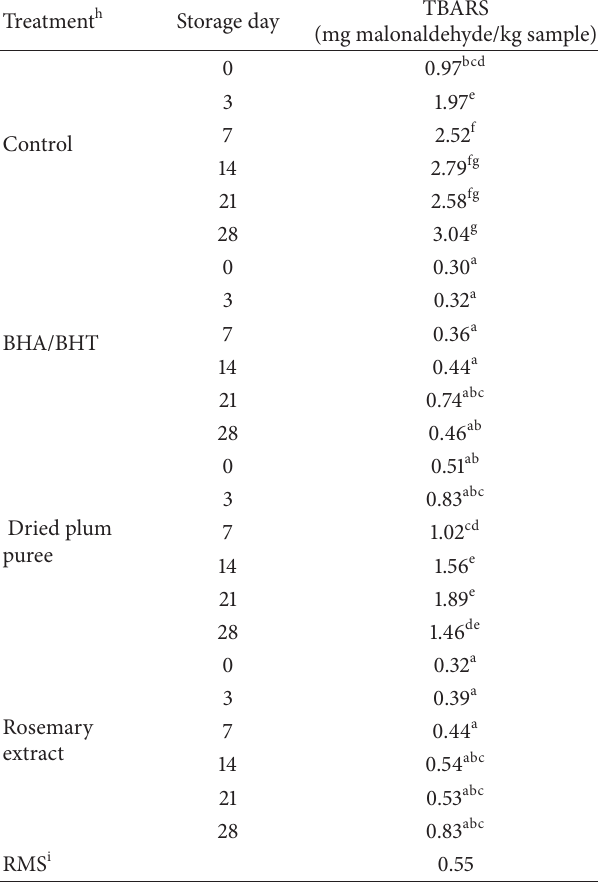
Table 3: Least square means for TBARS values of irradiated ground beef patties treated with/without antioxidants and stored at 4 ∘ C for 28